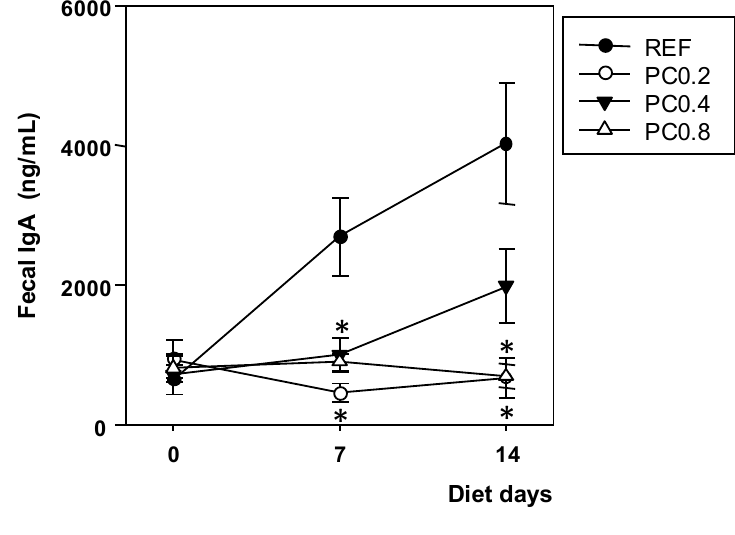
Figure 3. Effect of cocoa polyphenol-enriched diets on fecal IgA concentration at